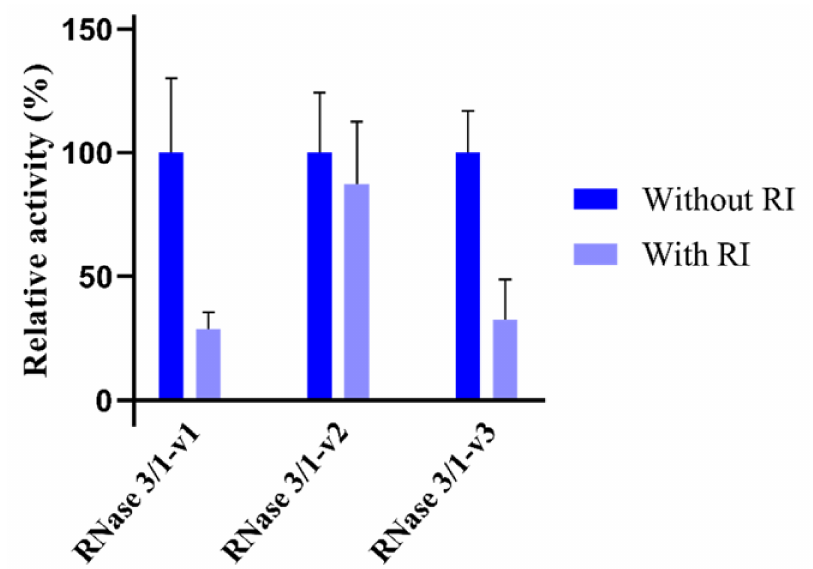
Figure 5. Ribonuclease inhibitor (RI) percentage of inhibition was determined by comparing the catalytic activity against CpA in the presence or absence of the inhibitor. Values represent the percentage of inhibition. The calculated activity in µ mols of product per µ mol of enzyme is shown in Figure S5. Results are shown from at least three replicates (mean ±